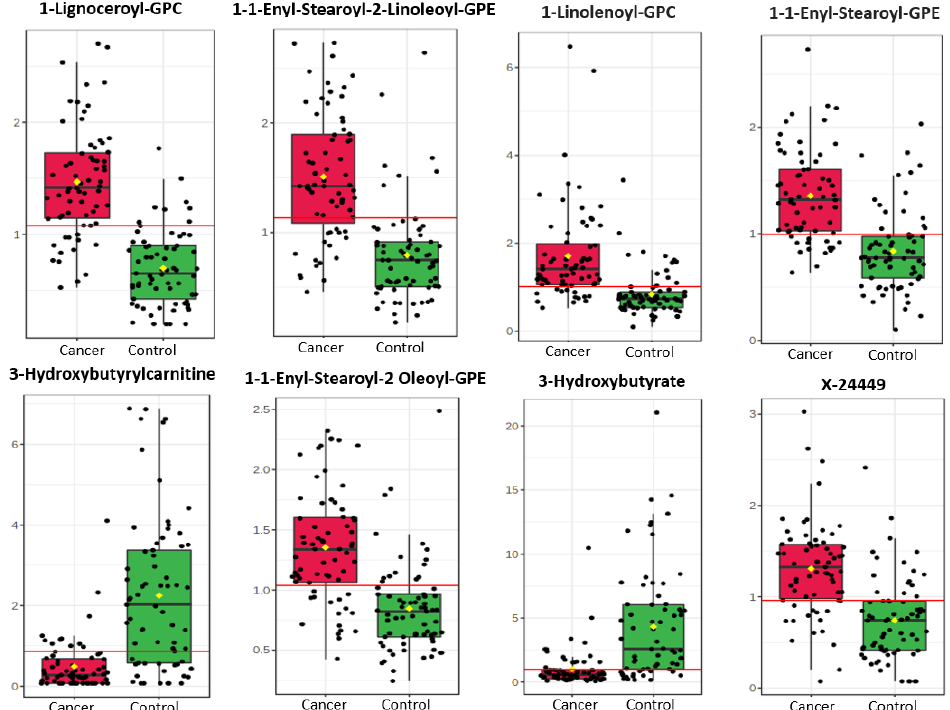
Figure 2. Box plot distribution of promising endometrial cancer diagnostic metabolites based on analyses of n = 67 cancers and n = 69 controls. The black dots along the Y axis in the box plots represent the concentrations of each metabolite while the yellow diamond represents the mean concentration for the group. The notch represents the 95% confidence interval around the median of each group. The horizontal red lines represent the optimal cut-off. Metabolites starting with X are unnamed; the pathways of these are unknown.